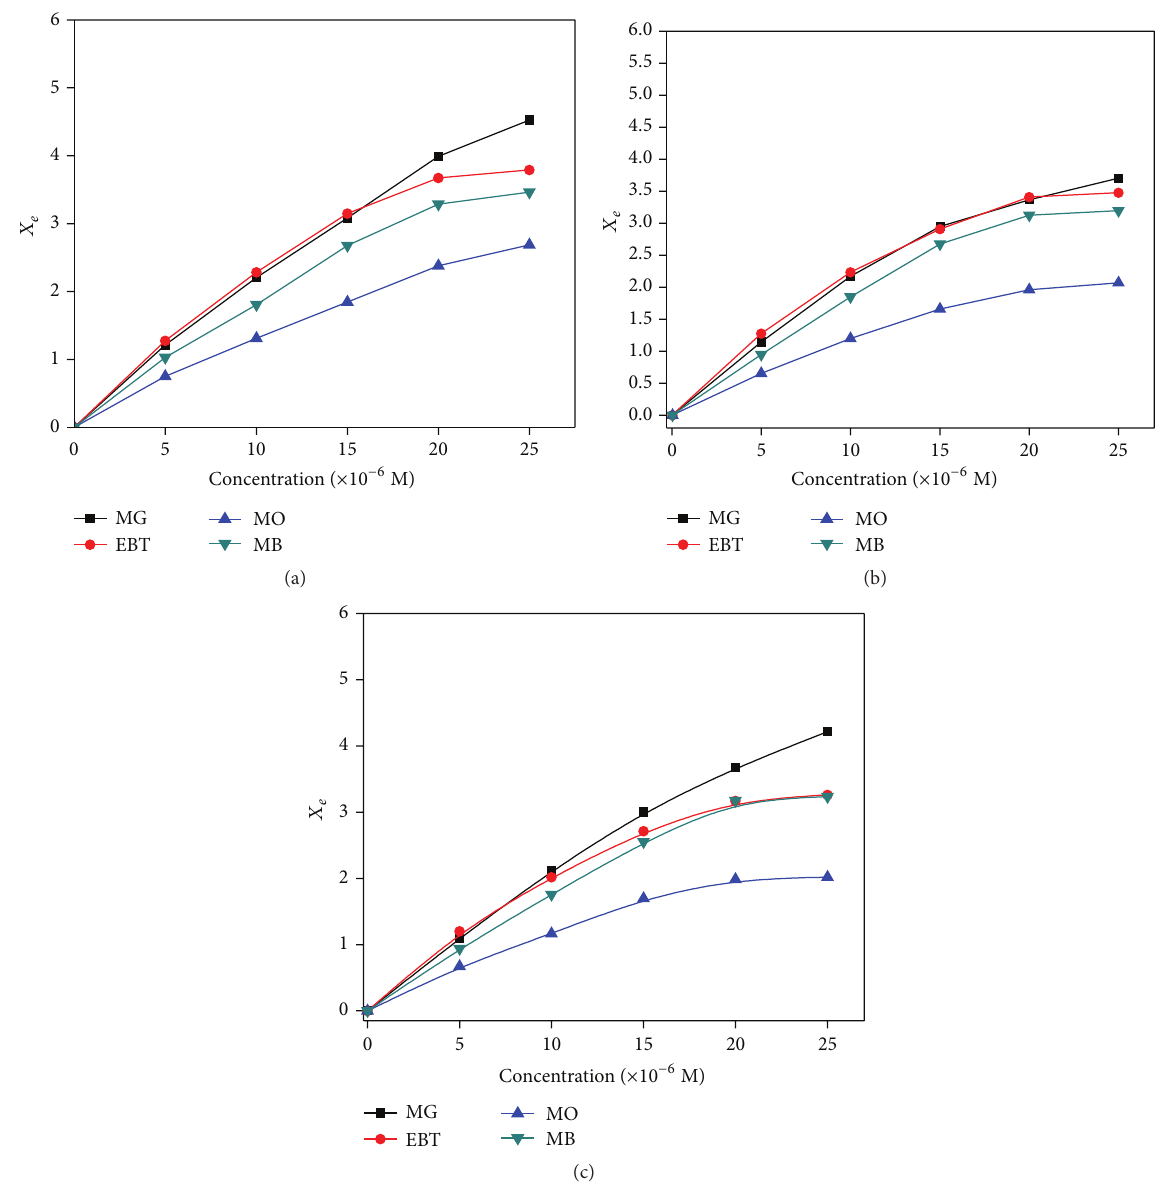
Figure 6: Adsorption isotherms for adsorption of MG, EBT, MO, and MB dyes on (a) KCuHCF, (b) KNiHCF, and (c) KCoHCF